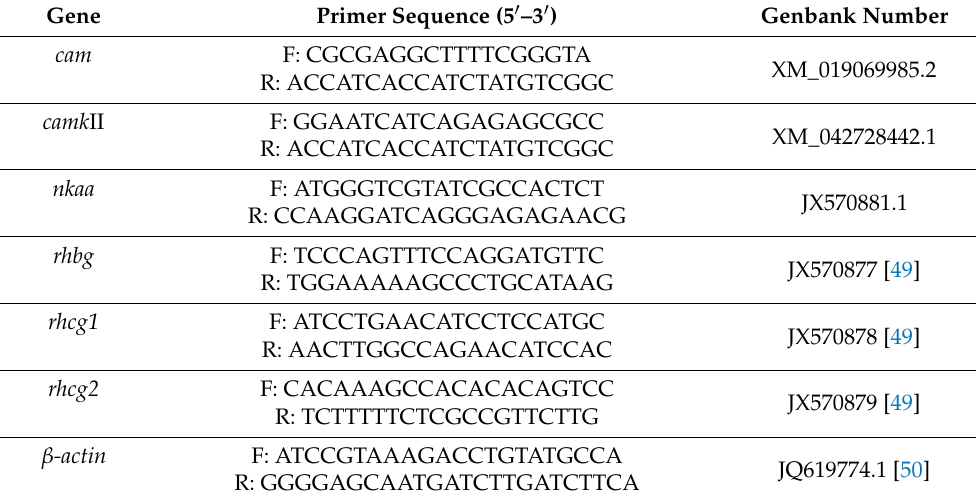
Table 1. Specific primer sequences for qPCR in the study.